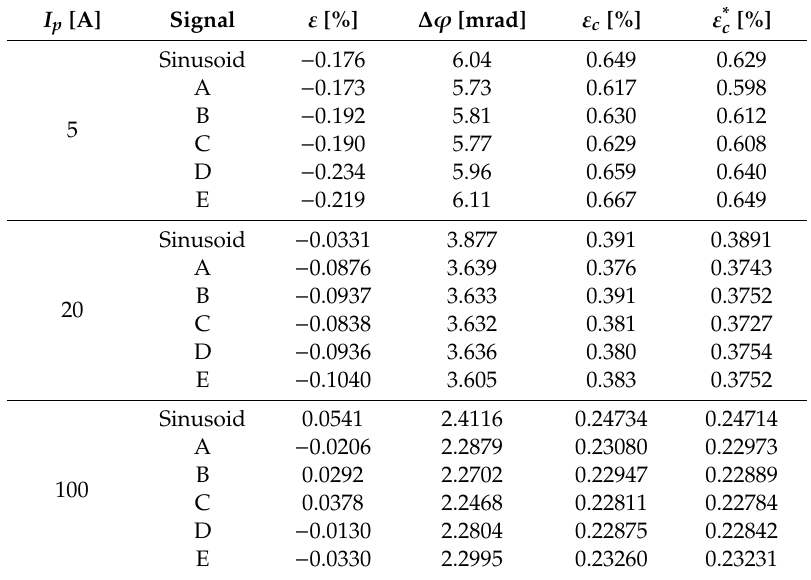
Table 7. Results for T2. Averages of ε , ∆ ϕ , ε c , ε ∗ c for the 50 Hz case and all the distorted signals, at 0.05 I pr , 0.2 I pr and I pr